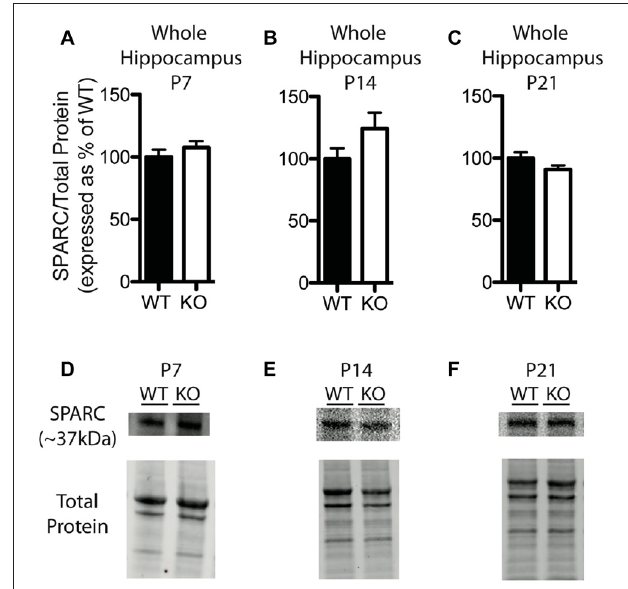
FIGURE 4 | Hevin expression is altered at postnatal day (P) 7 and P21 in the hippocampus of Fmr1 KO mice. (A–C) Hevin expression, determined via Western blotting, in the hippocampus of WT (black; n = 8) and Fmr1 KO (white; n = 8) mice at P7, P14 and P21, respectively. Bands representing hevin were normalized against the total protein within the same lane on the membrane and cross gel controls, then expressed as a percent of the average level of hevin in the WT group. (D–F) Representative western blots show hevin ( ∼ 130 kDa) in hippocampal samples (30 µ g of protein per lane) from WT and Fmr1 KO mice at P7, P14 and P21, as well as the total protein within each lane. Statistical differences were denoted with either a single asterisk, P < 0.05, or a triple asterisks, P < 0.0005.